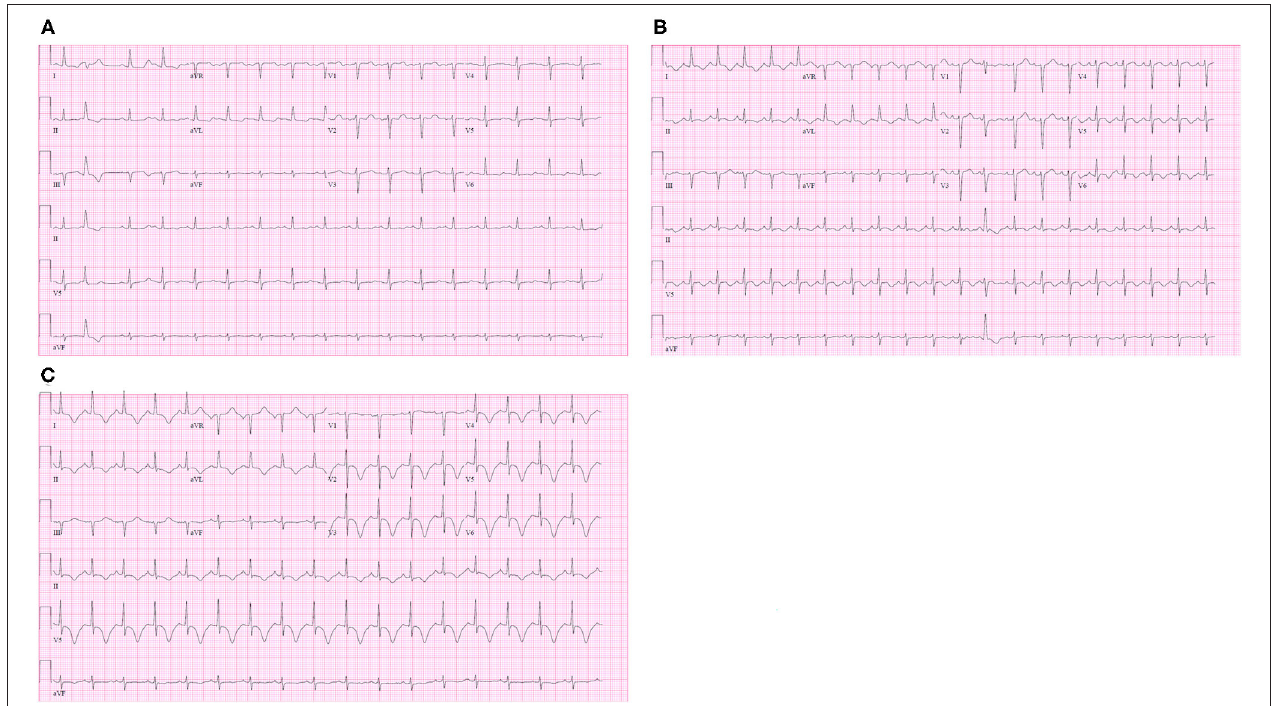
FIGURE 3 | (A) Admission electrocardiogram (ECG) showed normal QTc interval and non-specific T wave changes; (B) ECG on the post-trauma day (PTD) 3 revealed new-onset QTc prolongation and T wave inversion on the lateral leads (aVL, V5, and V6); (C) ECG on PTD 4 revealed worsening TWI on leads I, II, aVL and